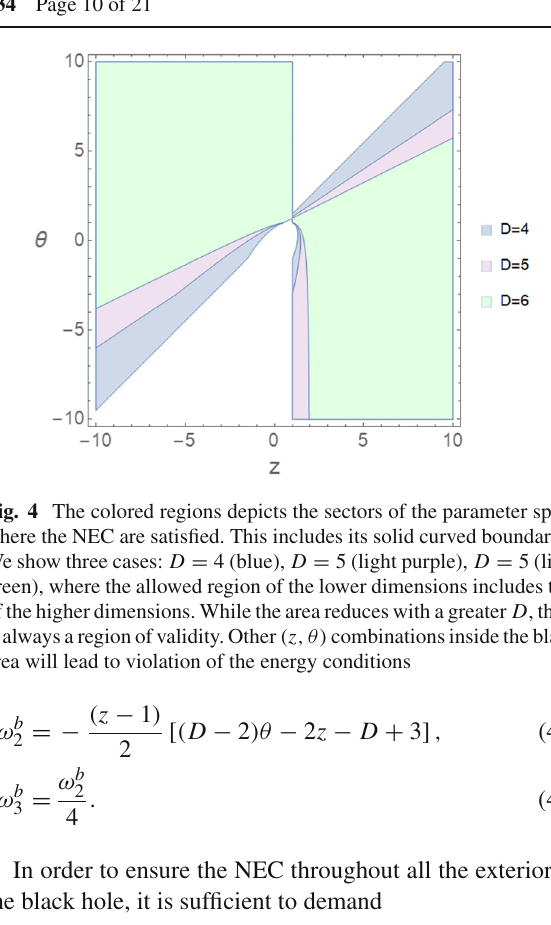
Fig. 4 in the presence of the black hole, and exactly coincide with those of